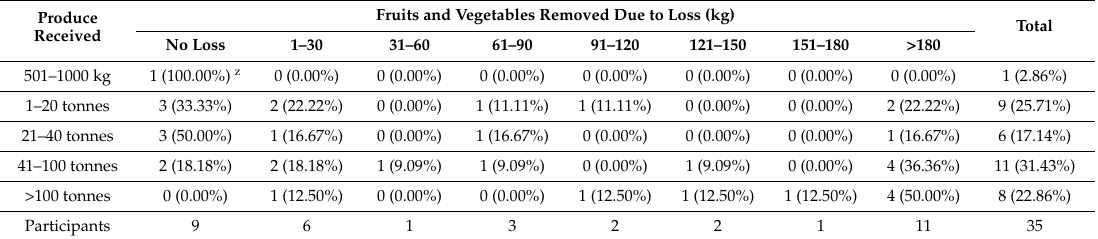
Table 1. Relationship between received fresh fruits and vegetables and weekly loss levels reported by participants at the Canning Vale Wholesale Market, Perth Western Australia.